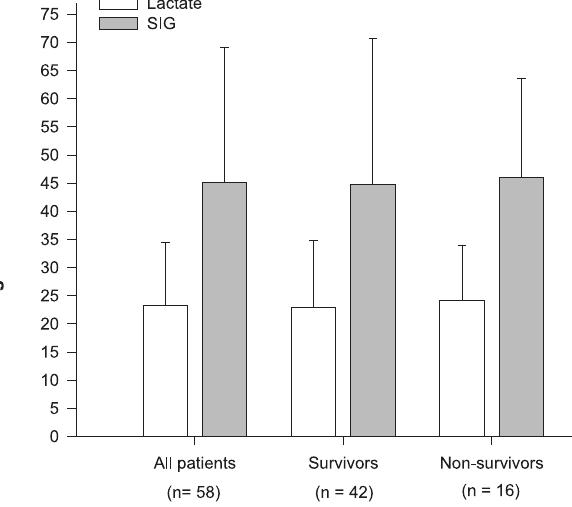
Figure 1 - Percentage of metabolic acidosis due to lactate and the strong ion gap (SIG). Metabolic acidosis was mainly due to the SIG in all groups; the percentage due to lactate was significantly lower than that due to the SIG in all groups ( P < 0.001). Regarding ICU survivors and nonsurvivors, no difference was found in the percentage of metabolic acidosis due to lactate ( P = 0.753) or due to the SIG ( P =